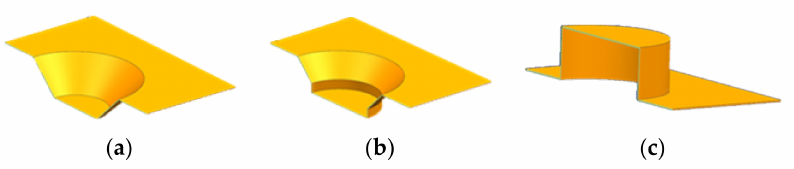
Figure 5. The forming model of each stage: ( a ) the first stage; ( b ) the second stage; ( c ) the third